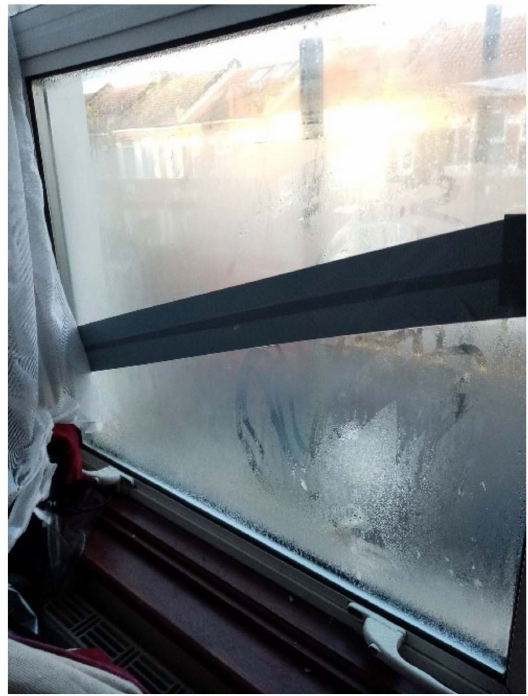
Figure 20. Participant.Survey10.